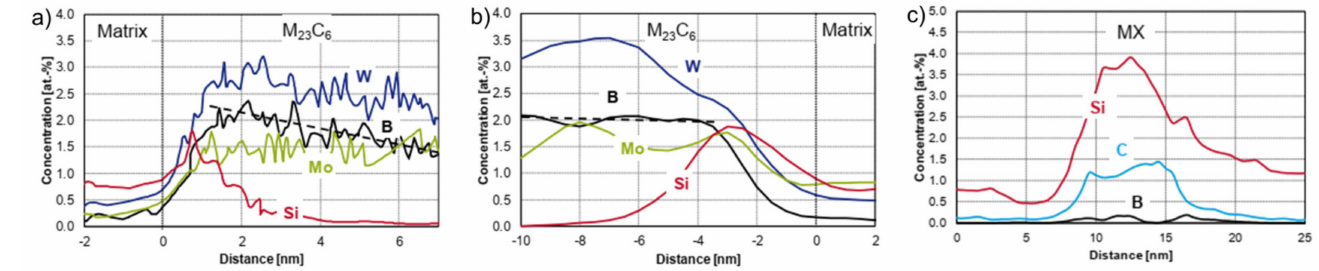
Figure 18. Proxigram analysis showing quantitative B, W, Mo, Si concentration profiles across M 23 C 6 /matrix ( a , b ) and B, C, and Si concentration profiles across MX/matrix ( c ) interface in the SuperVM12 steel after creep at 650 ◦ C for 23,844 h. Reprinted with permission from Ref. [54]. Copyright 2019 ASM